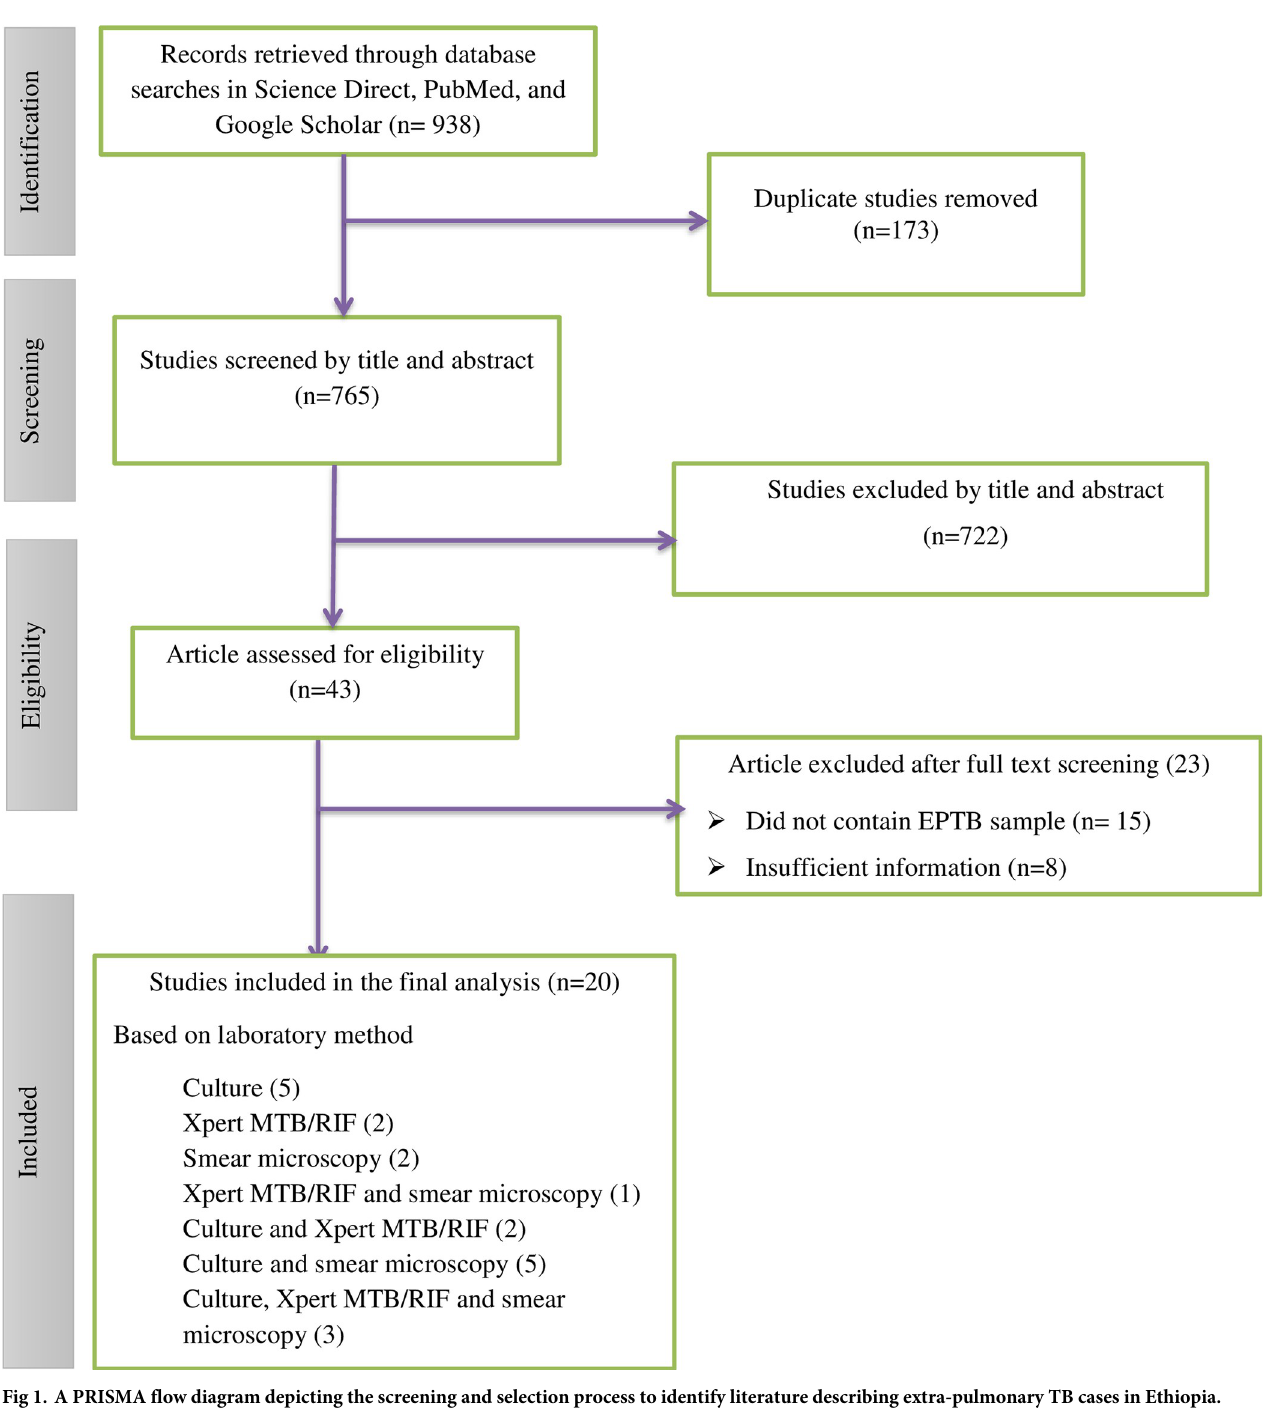
Fig 1. A PRISMA flow diagram depicting the screening and selection process to identify literature describing extra-pulmonary TB cases in